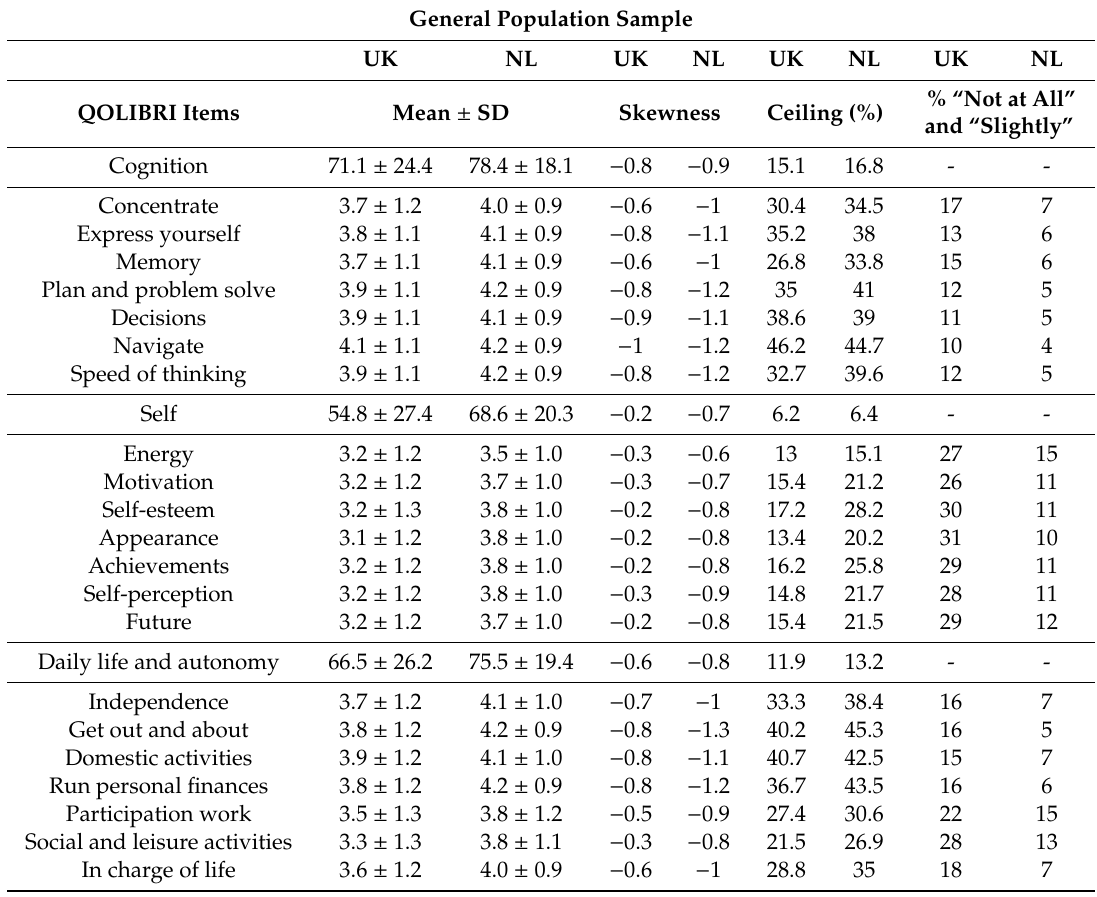
Table A1. Characteristics of the QOLIBRI